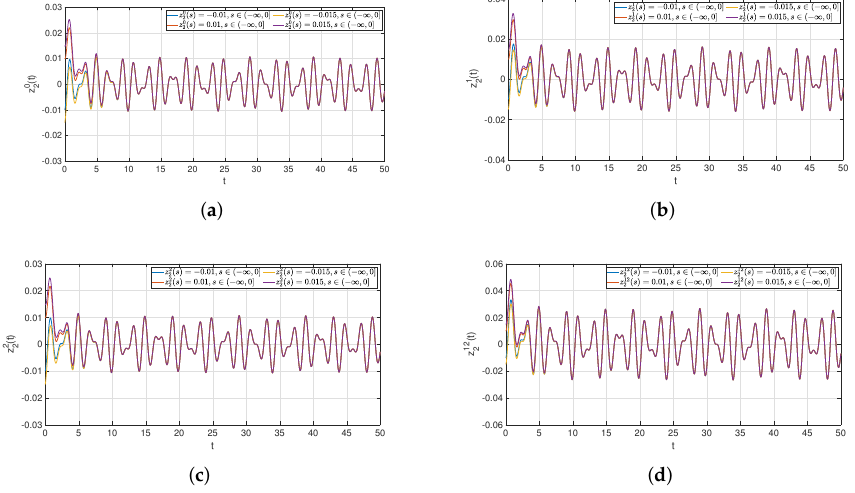
( t ) , z 1 ( t ) , z 2 ( t ) , z 12 ( t ) of system (1) with different initial values. ( a ) z 0 2 2 2 2 with different initial values; ( c ) z 2 2